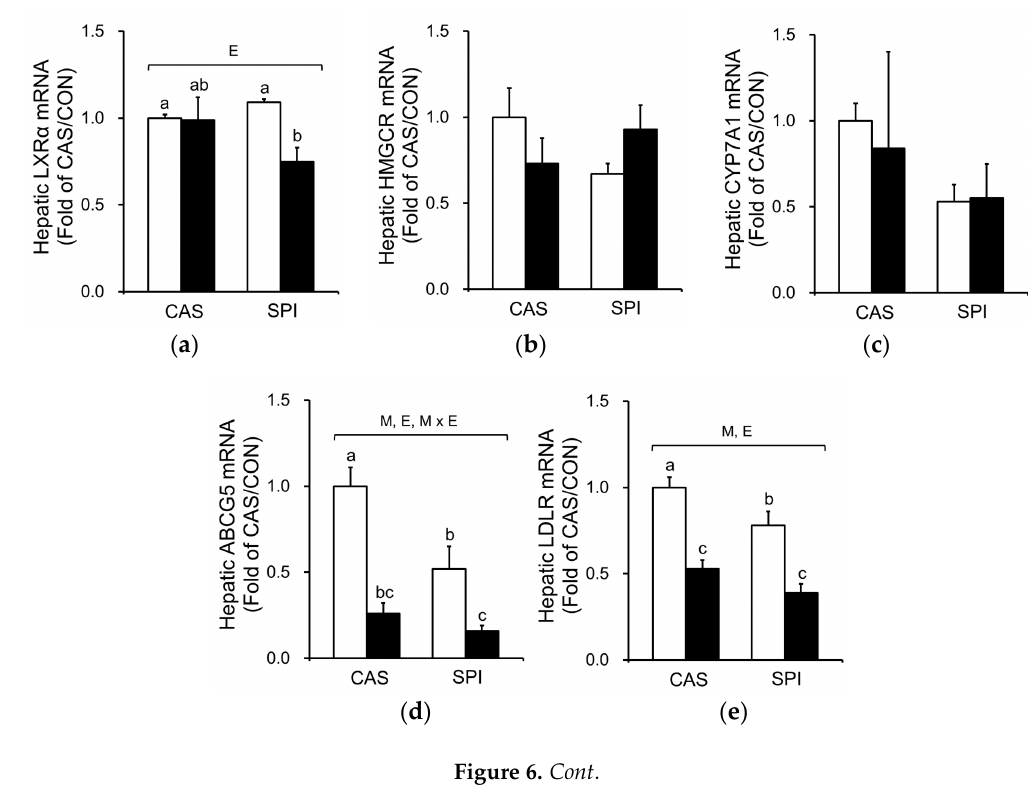
Figure 5. Effects of maternal diet on serum and hepatic lipid levels in adult offspring fed an ethanol diet. Serum ( a ) triglyceride, ( b ) total cholesterol, and ( c ) HDL cholesterol levels ( n = 8); Hepatic ( d ) triglyceride and ( e ) cholesterol levels ( n = 7 ‒ 8). Data are expressed as means ± SEM. Significant effects of maternal diet (M), offspring ethanol diet (E), and their interaction (M × E) were analyzed by two-way ANOVA ( p < 0.05). Means without a common superscript significantly differ based on post-hoc analysis ( p < 0.05). Data that were not normally distributed were log-transformed before the statistical analysis. CAS, casein; SPI, low-isoflavone soy protein isolate; CON, control; EtOH, ethanol.